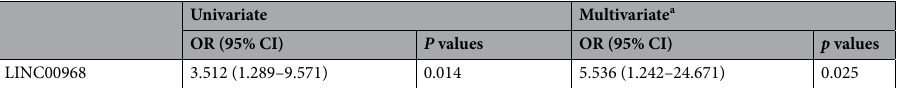
Table 4. Logistic regression analyses for the independent predictors of CAD. OR odds ratio, CI confidence interval. a Adjusted for sex, SBP, hypertension and